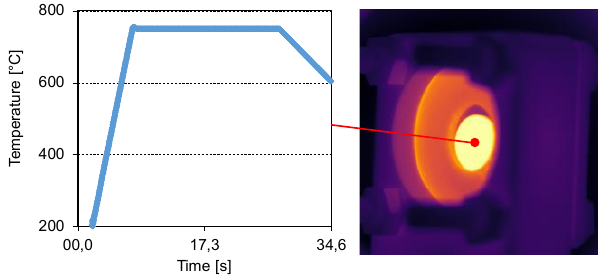
Fig. 6. Example of a regulated laser heating on a UO 2 sample. Left: measured temperature with the pyrometer at the sample surface in case of 100°C/s heating ramp followed by 20s plateau at 750°C. Right: Observation of the sample with the thermal camera during the temperature plateau.